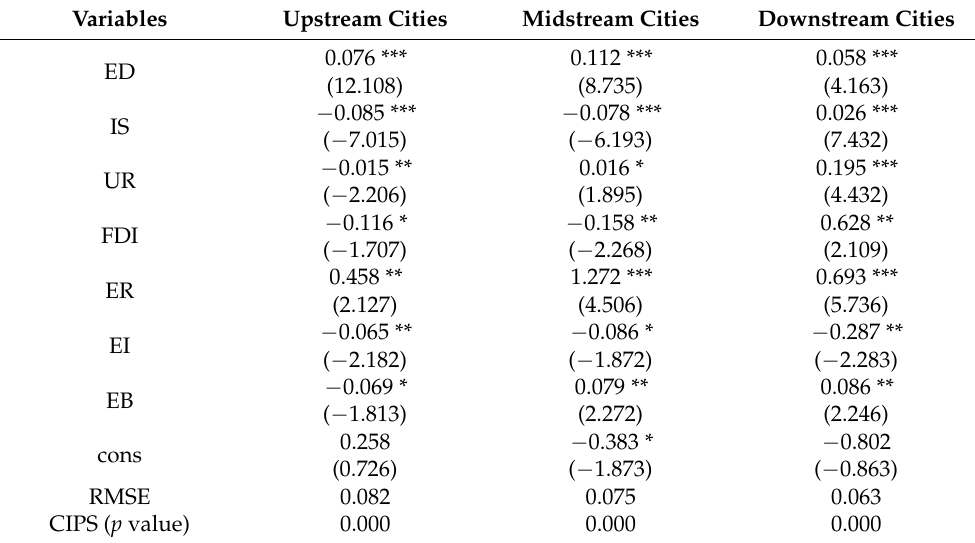
Table 7. CCE estimation results of cities in the YRB upstream, midstream and